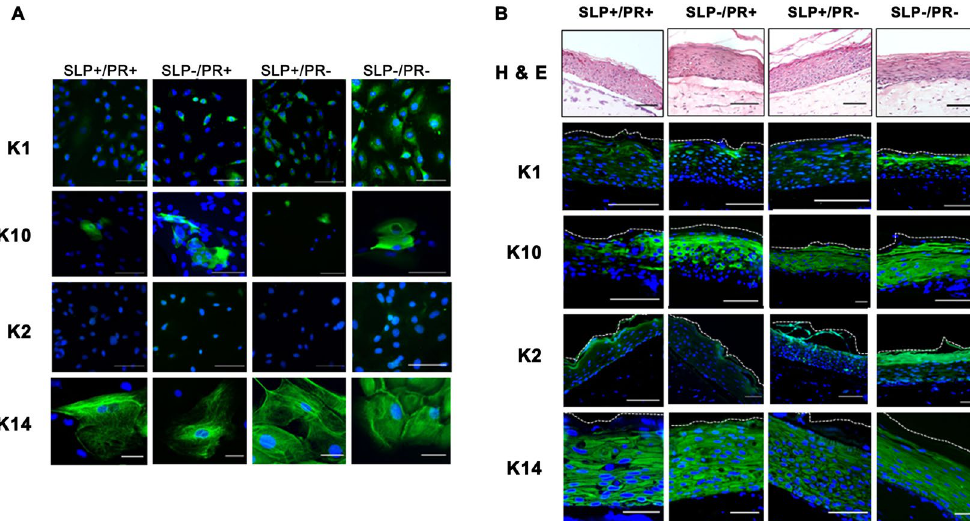
Figure 2. Effect of SLP and PR on the expression of K1, K10 and K2 in 2D and 3D cultures. ( A ) NHEK (50,000 cells) were grown with 100,000 irradiated 3T3 feeder cells on glass coverslips in 50 µ l medium and after the cells had attached, 1 ml of four different RM + media conditions, PR containing RM + with or without SLP containing FCS (SLP + /PR + , SLP − /PR + ), no PR in RM + with or without SLP containing FCS (SLP + /PR − , SLP − /PR − ) was added. The cells on coverslips were immunostained for K1, K10, K2 and K14. ( B ) NHEK (500,000 cells) were grown in 3D cultures in an insert (pore size 0.4 µ m) based method. Primary dermal fibroblasts (100,000 cells/ insert) were used in 400 µ l collagen matrix to support the growth of NHEK. The cells were grown at air-liquid interface for 10 days with 4 different media conditions ( A : SLP + /PR + , B : SLP − /PR + , C : SLP + /PR − and D : SLP − / PR − ), fixed in 4% (w/v) paraformaldehyde/PBS and paraffin embedded. Sections of 5 µ m thickness were cut, de- waxed, re-hydrated, H & E stained, de-hydrated and mounted using DPX medium. Nikon Eclipse 80i Stereology Microscope was used for recording. (Scale bar = 100 µ m). To immunostain the 3D cultures, the re-hydrated sections were antigen retrieved, followed by immunostaining with antibodies against K1, K10, K2 and K14, the nuclei were counterstained with DAPI in blue, overlapping images of DAPI with keratin staining is shown as merged images. Leica DM4000B Epi-fluorescence microscope equipped with DFC350 camera was used for recording. (scale bar = 20 μ m). The upper most stratum corneum has been indicated by white dashed